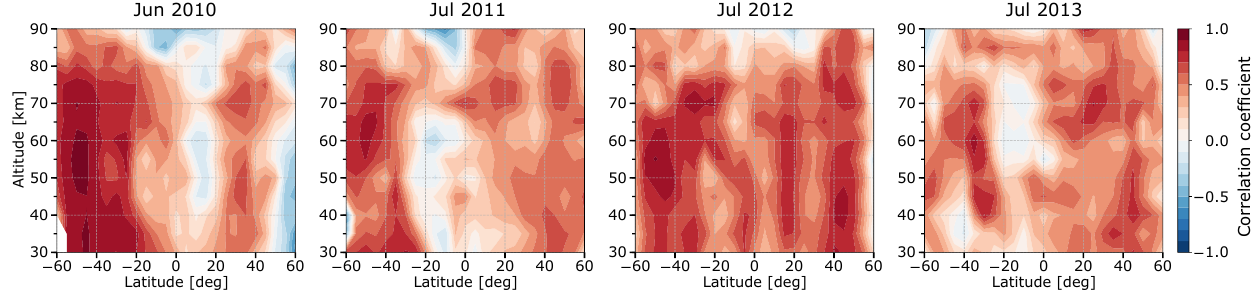
Figure 3. Latitude–altitude cross section of Pearson correlation coefficients between SABER GWMF and GOCE ARDF for boreal